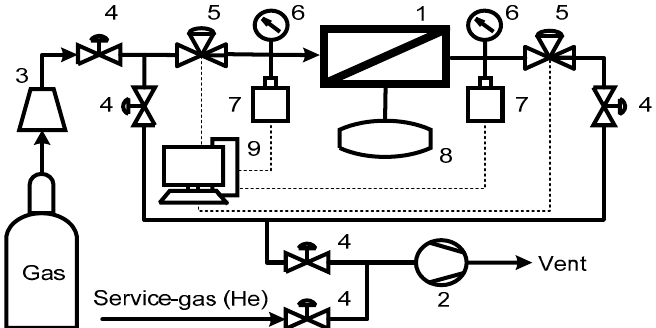
Figure 1. Schematic of the experimental setup for the single gas permeability test: 1—permeation cell;